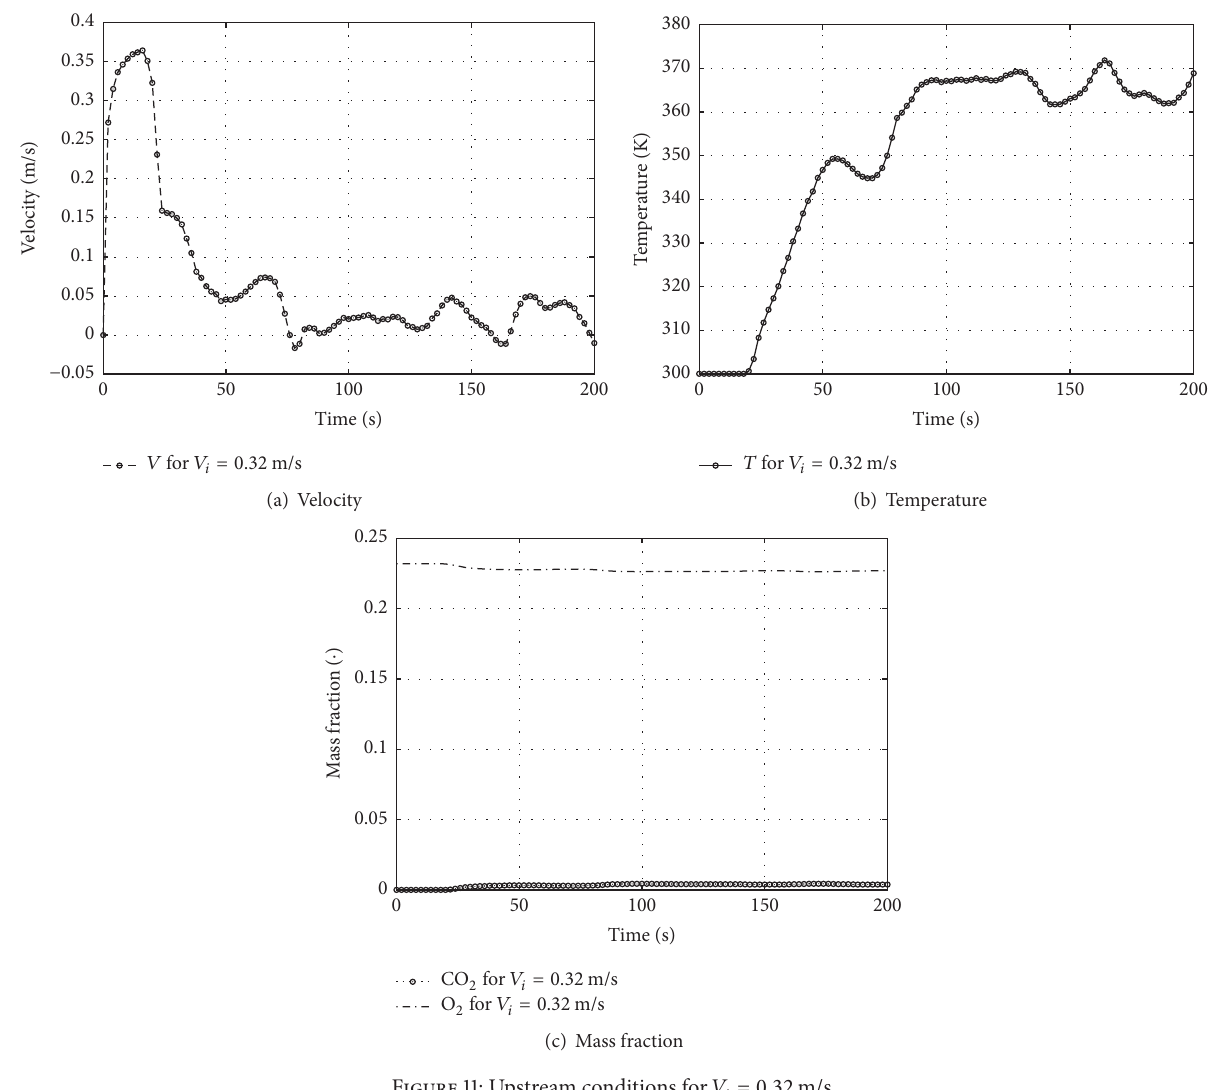
Figure 11: Upstream conditions for 𝑉 𝑖 = 0.32 m/s.